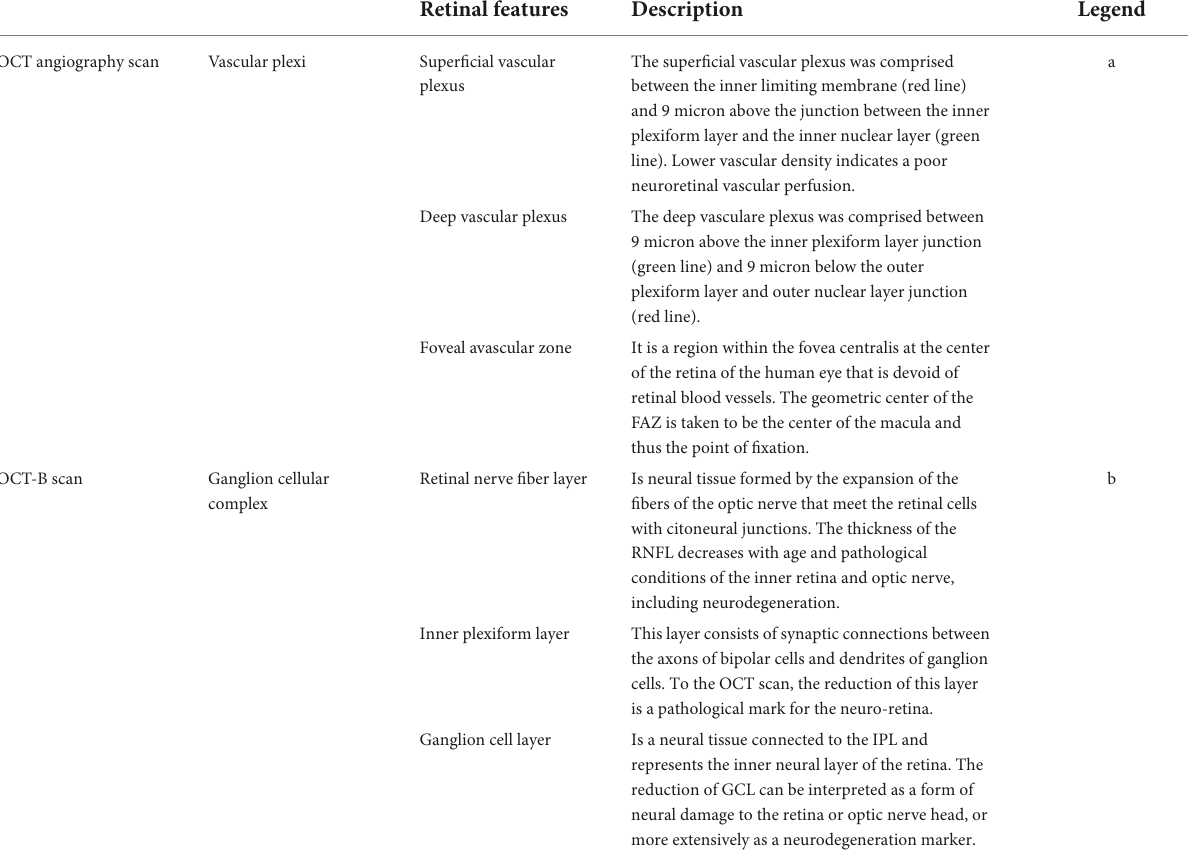
TABLE 1 Description of the retinal features shown in Figure 1